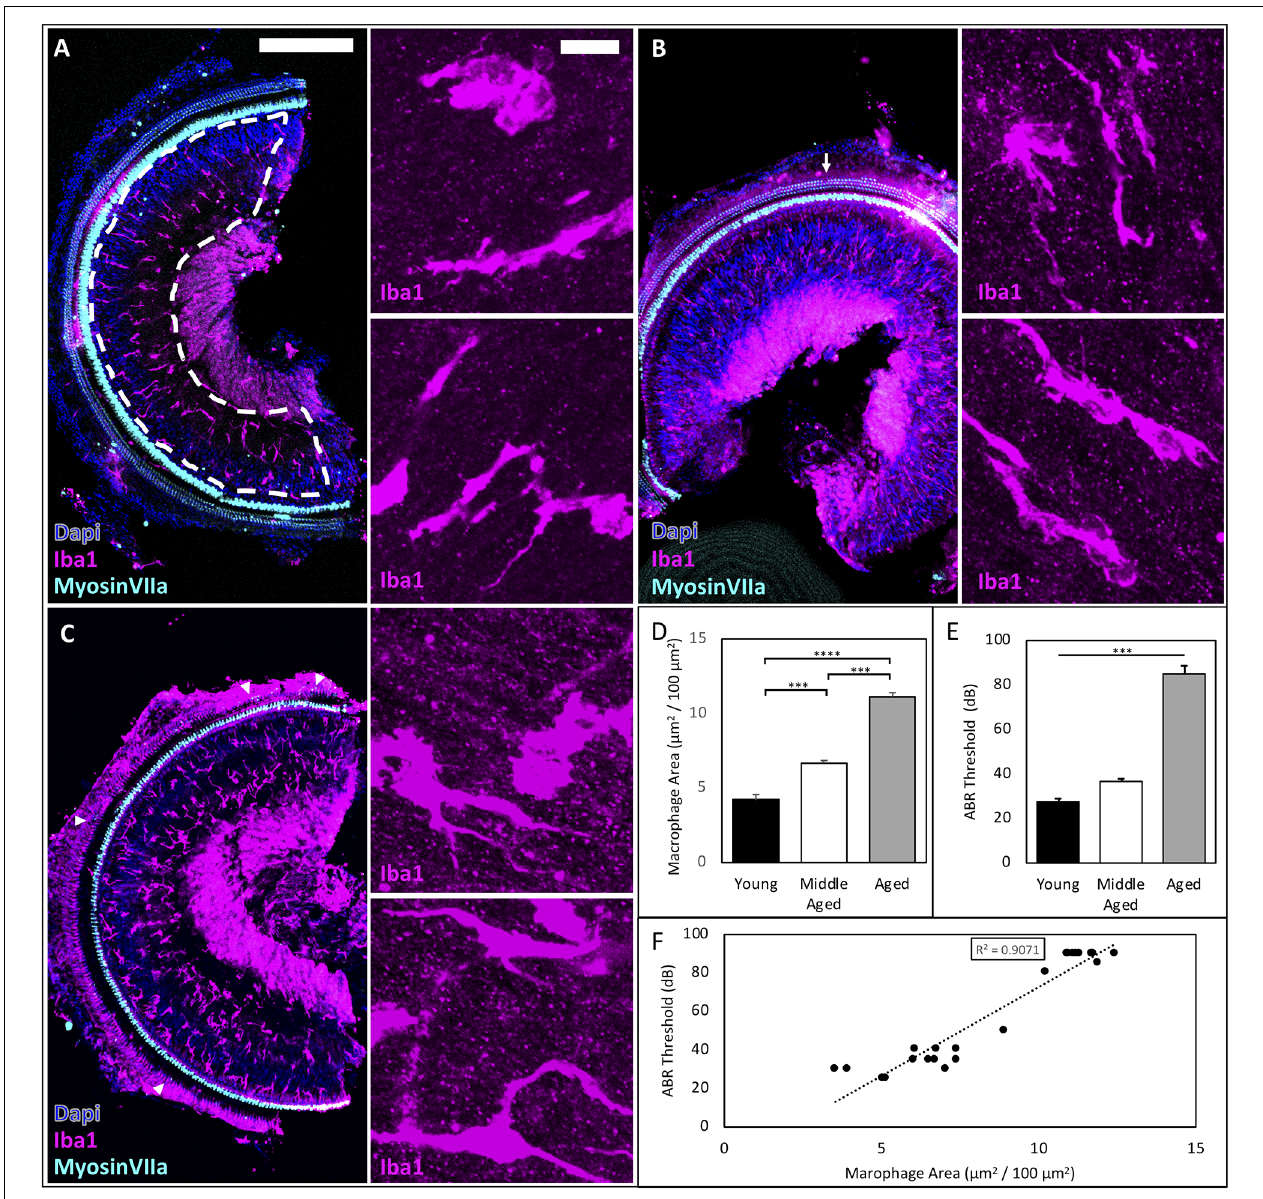
FIGURE 1 | ARHL-associated inflammation increases across the lifespan and correlates with the severity of hearing impairment in CBA/CaJ mice. (A–C) Representative images of young, middle-aged, and aged mice showing accumulation of cochlear macrophages in the OSL, scale bar = 200 µ m, inserts scale bar = 10 µ m. Myosin VIIA staining revealed minimal OHC loss (arrows) in middle-aged mice, while few OHC remained (triangles) in aged mice. (D) Significant differences were found between all age groups. ∗∗∗ p < 0.001, ∗∗∗∗ p < 0.0001. (E) ABR Threshold increases with age confirming late-onset ARHL. ∗∗∗ p < 0.001. (F) Regression analysis between macrophage area ( µ m 2 /100 µ m 2 ) and ABR Threshold to clicks (dB) reveals a significant linear correlation R 2 = 0.9081, p < 0.002.